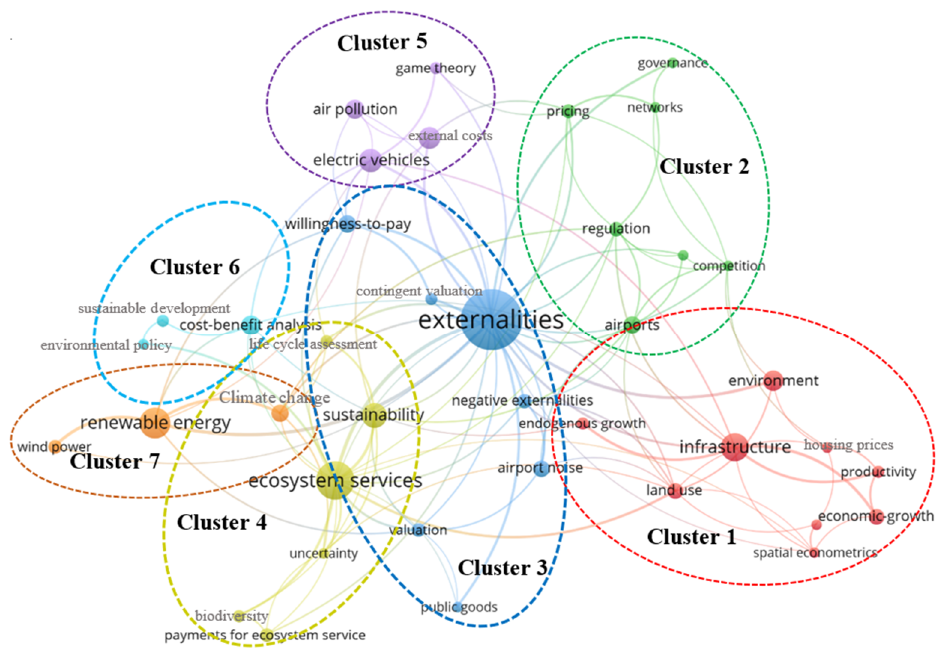
Figure 5. Main research domains of infrastructure externalities and their relatedness. VOSviewer forms a network by considering the closeness and strength of existing links and uses different colors to indicate different clusters of topics [42]. Keywords within the same cluster have closer internal relationships. The results showed that the keywords were classified into seven significant